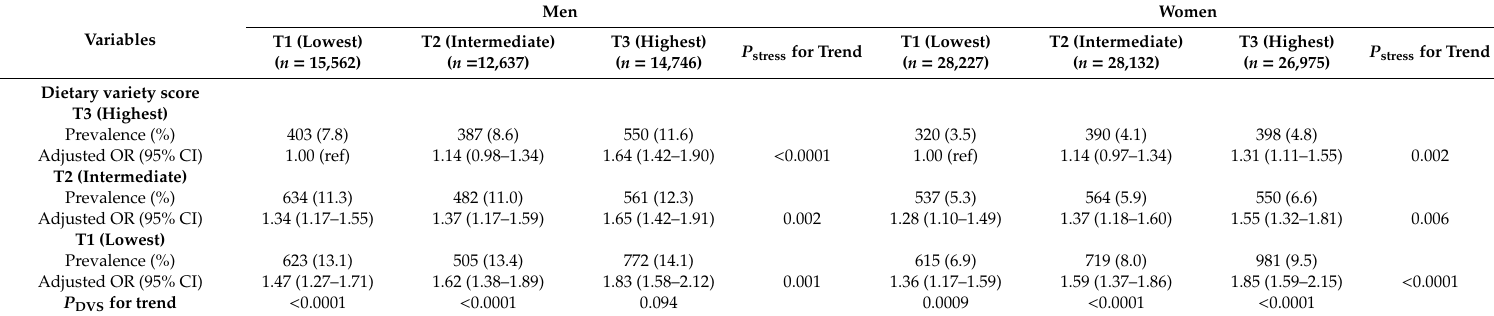
Table 4. Odds ratios (95% confidence intervals) for diabetes by tertiles of stress levels and dietary variety score.